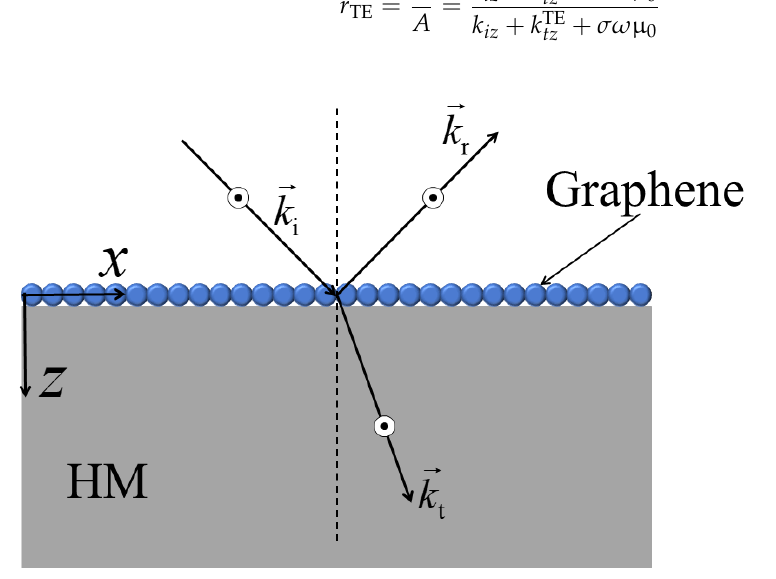
Figure A1. Schematic of electromagnetic wave scattering at the interface of vacuum and a graphene- covered